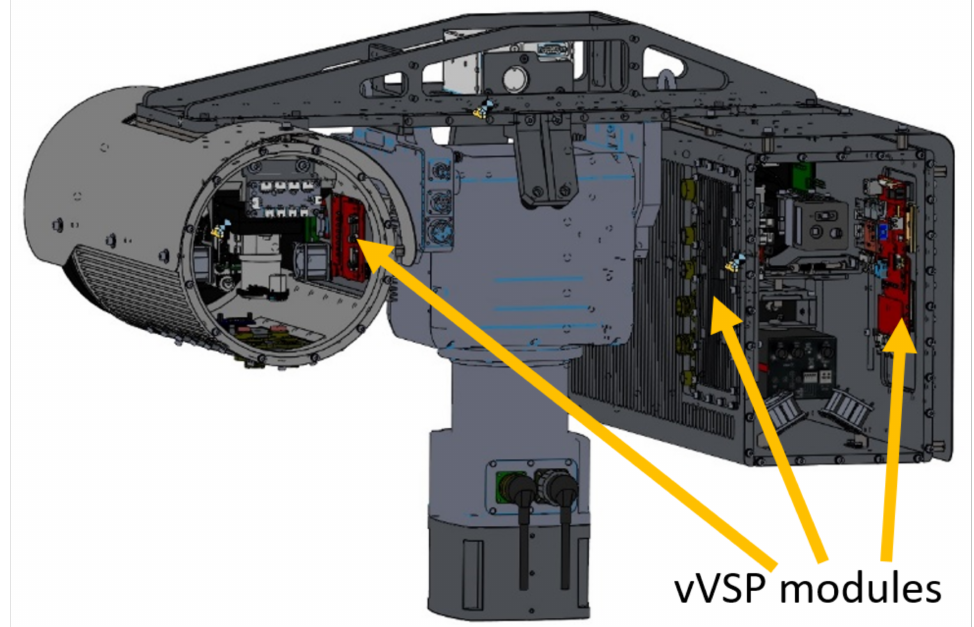
Figure 17. Positioning of VVSP modules in VMSIS3